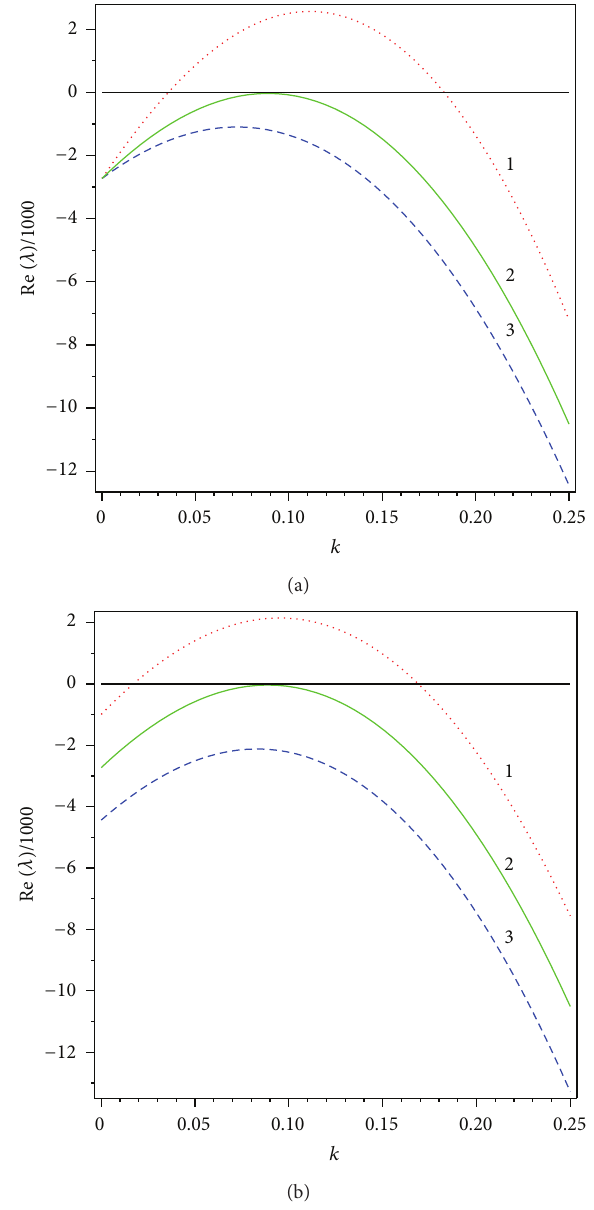
Figure 2: The dispersion relation Re (𝜆) . The critical mode 𝑘 = 𝑘 𝑐 is obtained for the first unstable point at V = V 𝑐 and 𝑁 = 𝑁 𝑐 , respectively, while other curves correspond to different values of 𝑁 and V . (a) 𝑁 = 0.32 , (1) V = 0.2 , (2) V = V 𝑐 , (3) V = 0.1 ; (b) (3) 𝑁 = 0.33 . V = 0.132 , (1)𝑁 = 0.31 , (2) 𝑁 = 𝑁 𝑐 ,